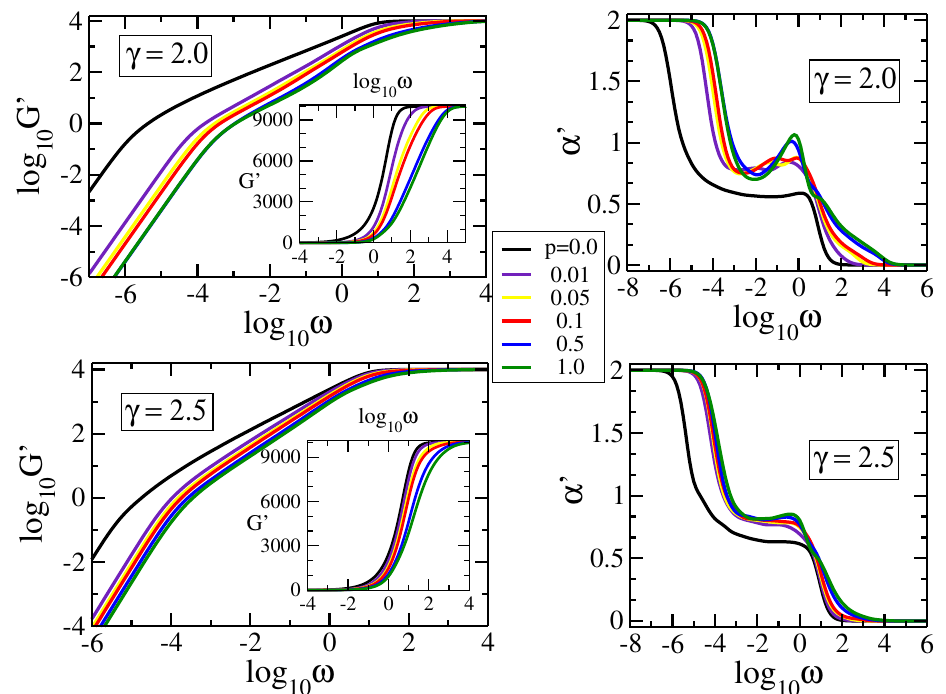
Figure 4. Storage modulus G (cid:48) and its derivative α (cid:48) for pDSFNs with N = 10,000 and various values of p and γ , as indicated. The frequency ω has units of σ = K / ζ